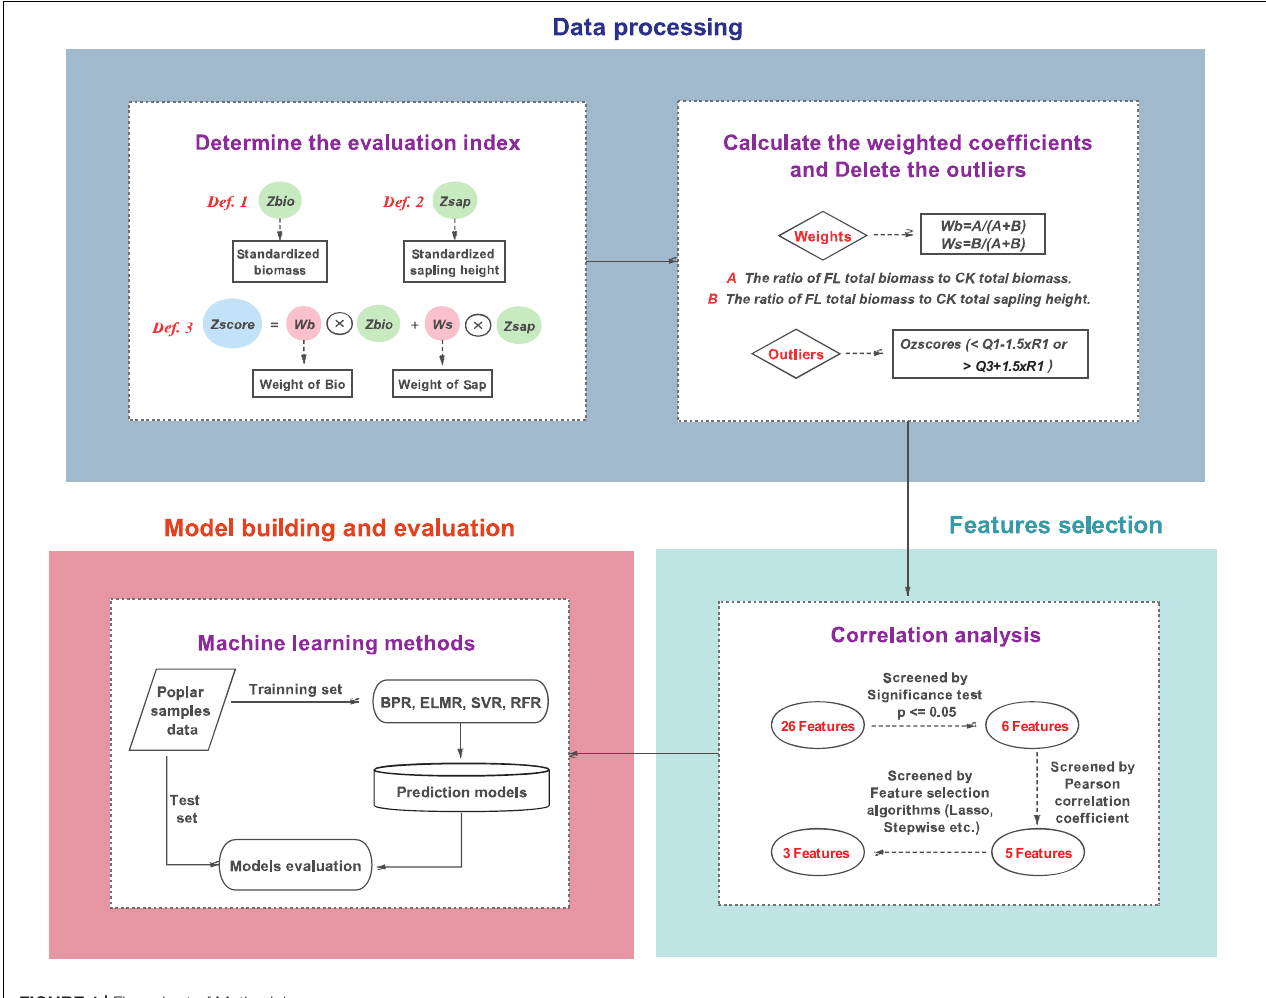
FIGURE 1 | Flow chart of